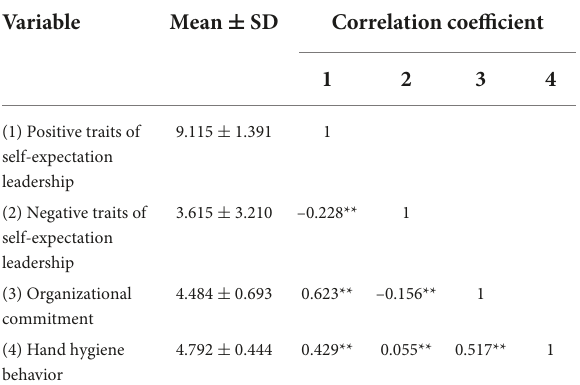
TABLE 2 Measurement score and correlation analysis of self-expectation leadership, organizational commitment, and hand hygiene